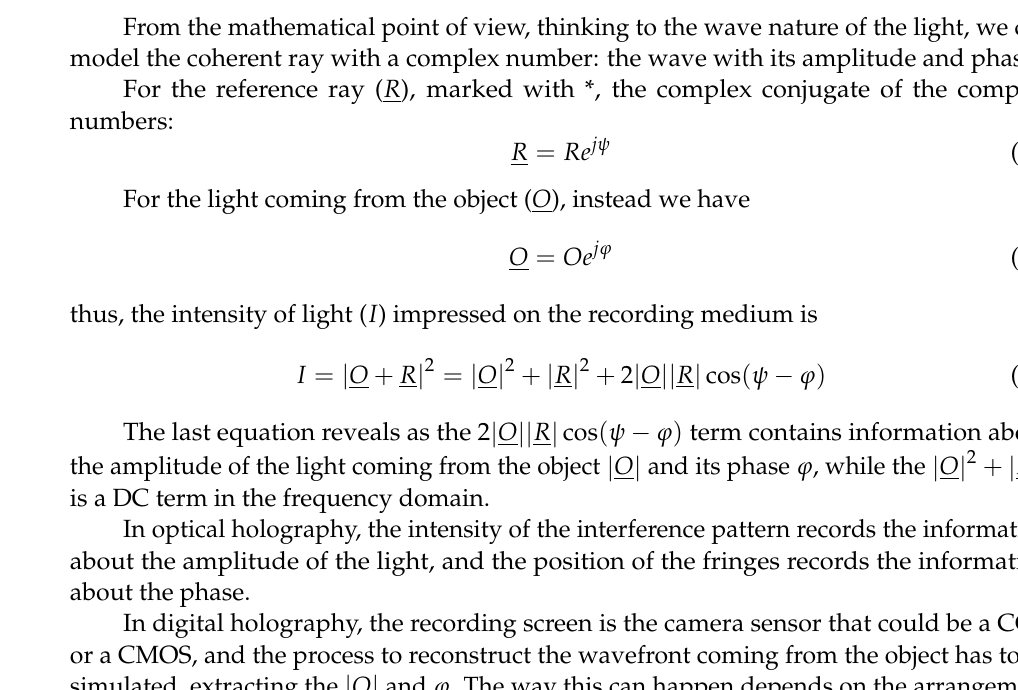
Figure 38. Alumina hologram, ( a ) Raw Hologram; ( b ) Refocused Hologram at z = 0; ( c – e ) are refocused holograms with different z values (depth of the recorded volume), to focus on specific particles. Reprinted with permission from Ref. [48] (2017). In particular, the setup used to record the holograms is shown in Figure 39, where the laser beam is open in a cylinder of light with a diameter coherent with the ROI, and the hologram is recorded by the optical system “Holography Camera and Lens”. The experimental apparatus related to DIH consists of: ⋅ Laser: Continuum MiniLite PIV ND:YAG lasers (532 nm, 5 ns pulse duration); ⋅ ND: Neutral Density filter; ⋅ LL: Laserline filter at 532 nm with a bandwidth of 1 nm (Andover 532FS02-50);